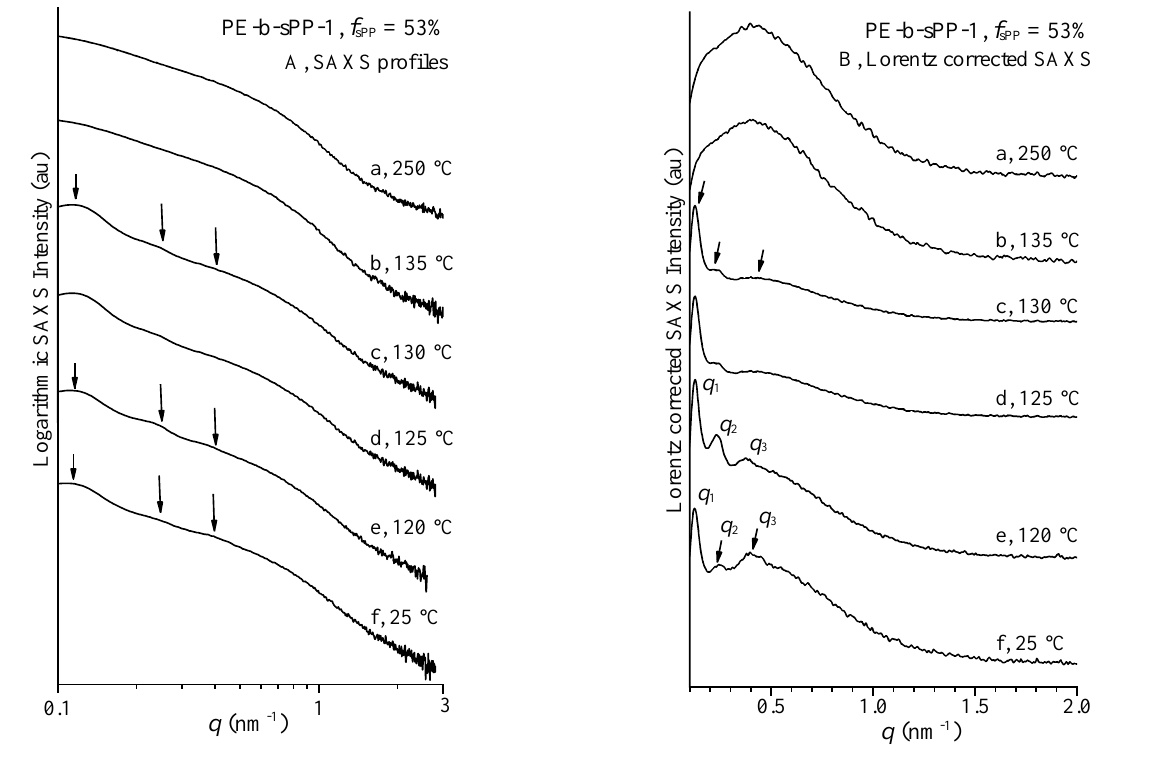
Figure 5. SAXS profiles ( A ) and Lorentz-corrected profiles ( B ) of the sample PE- b -sPP-1 with f sPP = 53% recorded at different temperatures (a–f) during cooling from the melt down to room temperature. The three correlation peaks q 1 , q 2 and q 3 , corresponding to lamellar stacks of PE and sPP, are indicated.